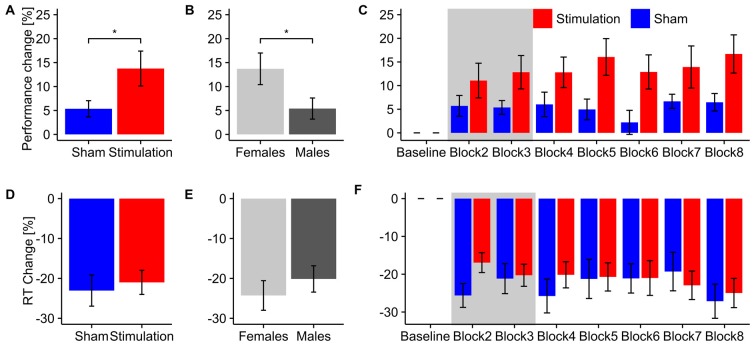
Behavioral Results. Top row: overall performance increase of the mental rotation task for (A)
stimulation and sham group and (B)
male and female subjects. Asterisks depicts significant differences (*<0.05). Error bars depict SEM. (C) Time-course of the performance increase for stimulation and sham group. Gray background indicates blocks during which tACS or sham stimulation was applied. Bottom row: overall change in reaction times for (D)
stimulation and sham group and (E) male and female subjects. (F) Time-course of reaction time changes for stimulation and sham group. Gray background indicates blocks during which tACS or sham stimulation was applied. Error bars depict SEM.